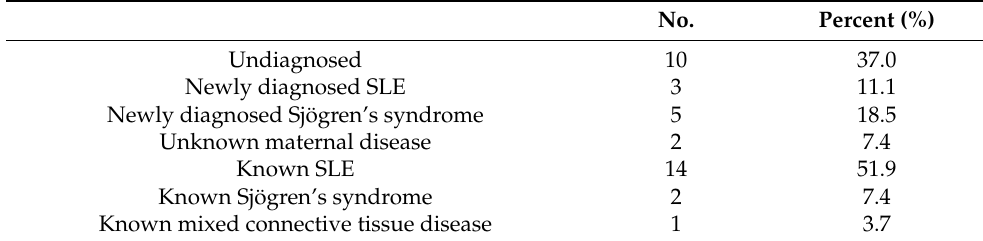
Table 4. Maternal diagnosis of NLE patients ( n =